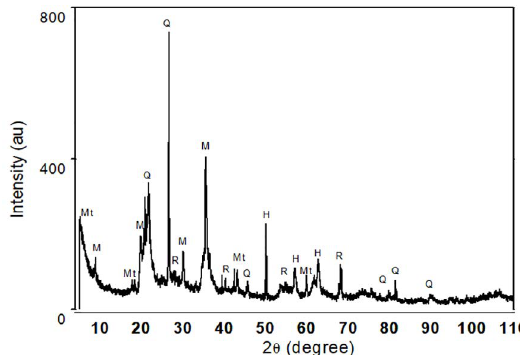
Figure 2. X-ray diffractogram of the Sulfatreat waste. M = muscovite mica ; Q = quartz, Mt = montmorillonite and H =